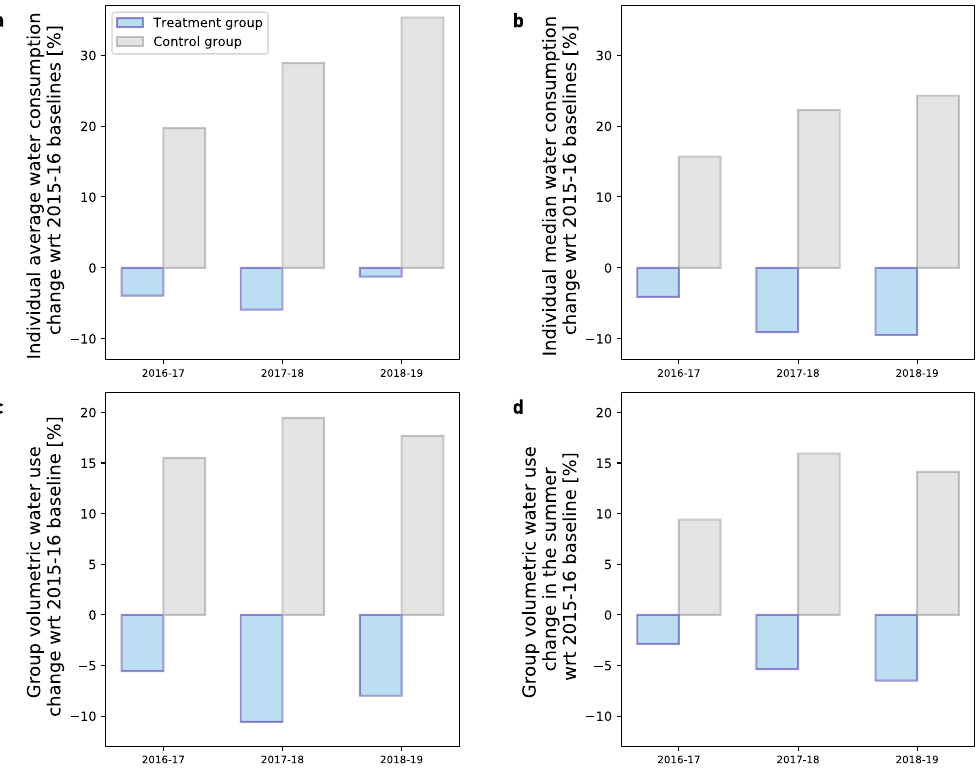
Fig. 1 Water consumption change. Water consumption changes are evaluated for the households in the treatment group (blue bars) and for the households in the control group (gray bars). Short-term, medium-term, and long-term water consumption changes are evaluated as averages ( a ) and medians ( b ) of percentage household water consumption changes with respect to individual baseline consumption levels, and total volumetric water use changes for the two groups over group-wide baseline consumption levels ( c ). Baseline consumption levels refer to pre-treatment average consumption levels observed in the period June 1st, 2015 – April 30th, 2016. Short term refers to the treatment period (June 1st, 2016 – February 2nd, 2017), medium term to a period one year after the treatment (June 1st, 2017 – February 2nd, 2018), and long term to a period two years after the treatment (June 1st, 2018 – February 2nd, 2019). Summer water consumption changes ( d ) are evaluated for the months of July and August in 2016, 2017, and 2018 as total volumetric water use changes for the two groups over group- wide baseline consumption levels (water consumption levels in July – August